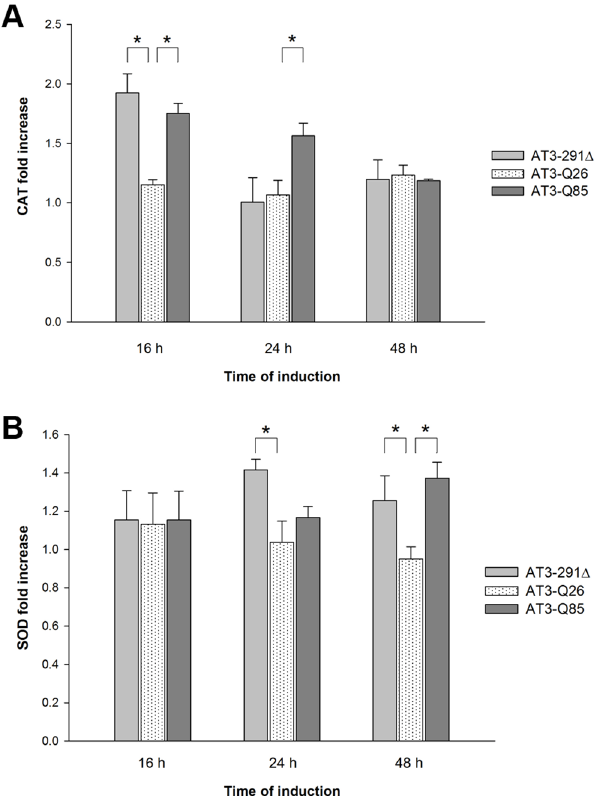
Fig 5. Antioxidant enzyme activity determination. A) CAT activity: the rate of H 2 O 2 decomposition was determined using the ferrous oxidation assay and absorbance was measured at 560 nm. Data are expressed as fold increase with respect to the empty vector strain level. Bars represent standard errors and are derived from at least three independent experiments (P < 0.05). B) SOD activity was determined as the rate of reduction of oxidized cytochrome c at 550 nm. Data are expressed as fold increase with respect to the empty vector strain level. Bars represent standard errors and are derived from at least three independent experiments (P < 0.05).